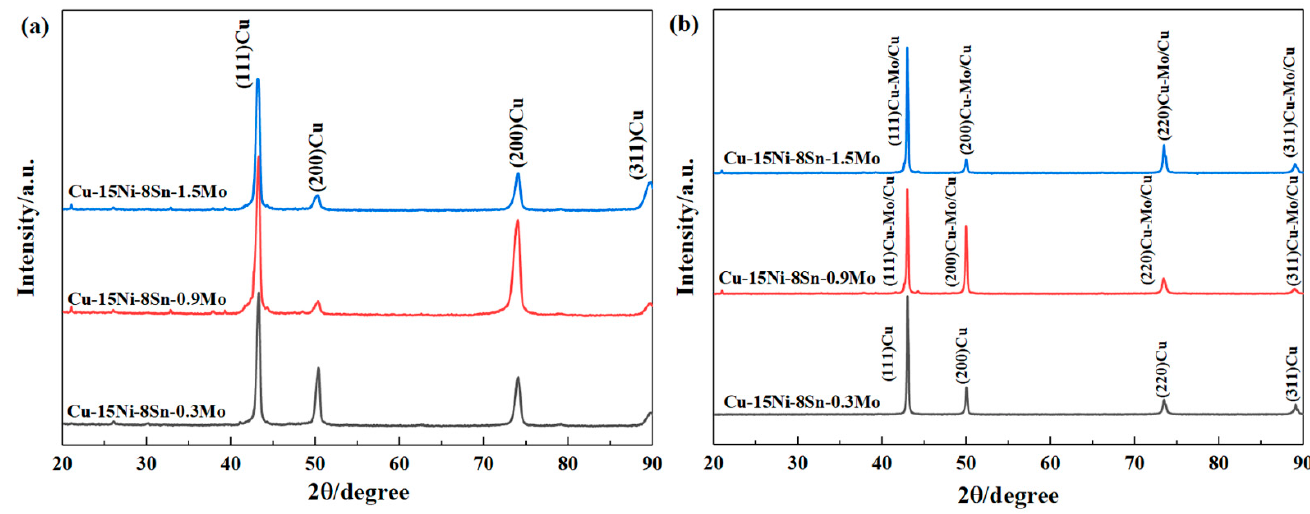
Figure 11. ( a ) XRD patterns of Cu–15Ni–8Sn–xMo (x = 0.3, 0.9, 1.5 wt.%) alloy at as-cast state and ( b ) after solid solution treatment at 900 °C for 4 h.